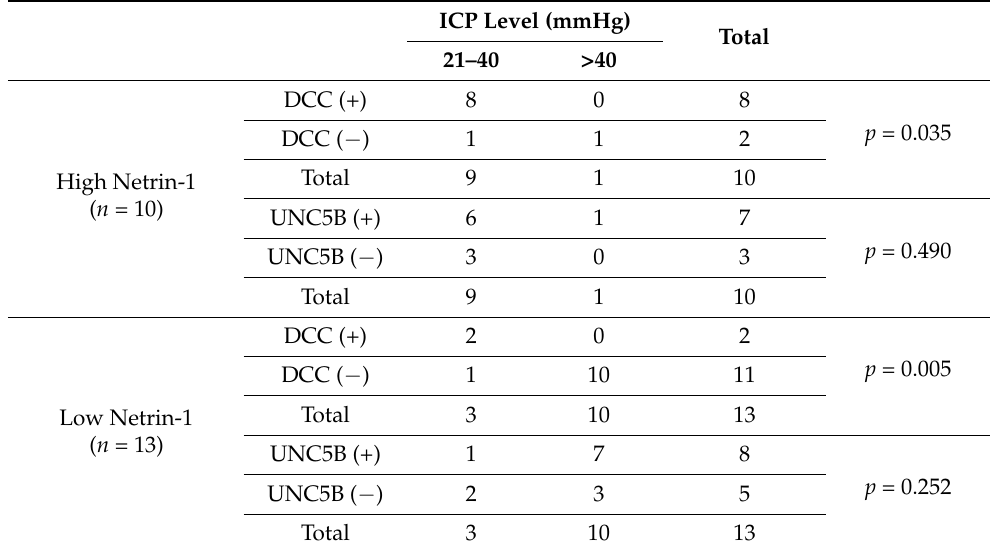
Table 4. Comparisons of ICP level between the high Netrin-1 group and the low Netrin-1 group (considering the expression of DCC and UNC5B